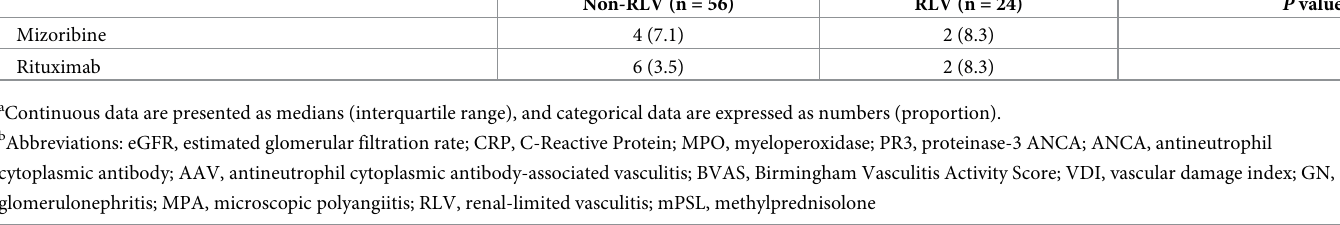
During the median follow-up period of 35 (range, 15–57) months, four (16.7%) and 24 (42.9%) patients in the RLV and non-RLV groups, respectively, relapsed ( P = 0.024, Table 2). Of the 28 relapse patients, one (25.0%) and 16 (66.7%) patients in the RLV and non-RLV groups, respectively, had a major relapse ( P = 0.077). The cumulative probabilities of relapse Table 2. Comparison of outcome data between RLV and non-RLV groups.